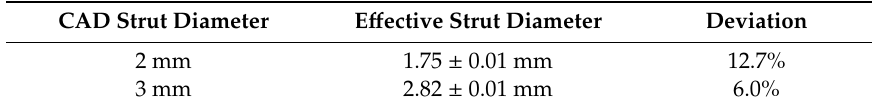
Table 3. Geometrical deviations being characteristic for the strut geometries.